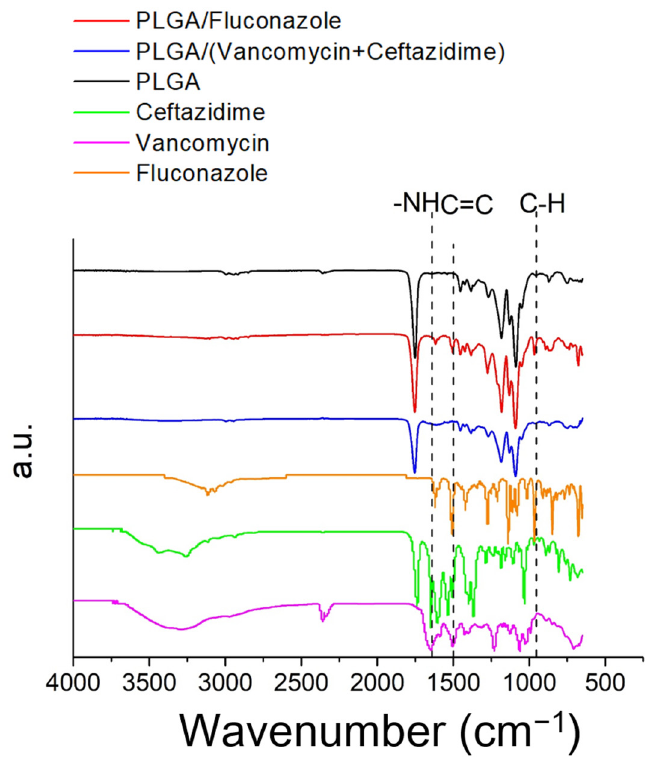
Figure 4. Fourier-transform infrared spectra of pure poly lactic- co -glycolic acid (PLGA) and antimi- crobial drug-loaded PLGA nanofibers.